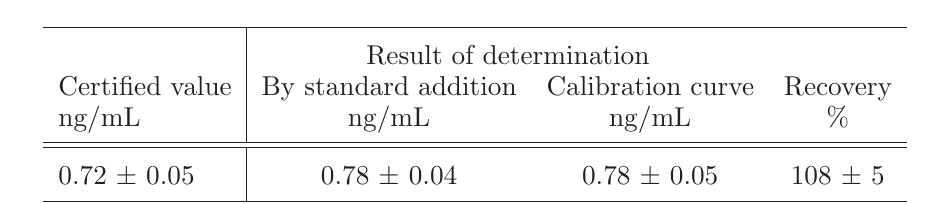
Table 5 Results of arsenic determinations in the certified reference standard material SLRS-3 by HG-GFAAS.